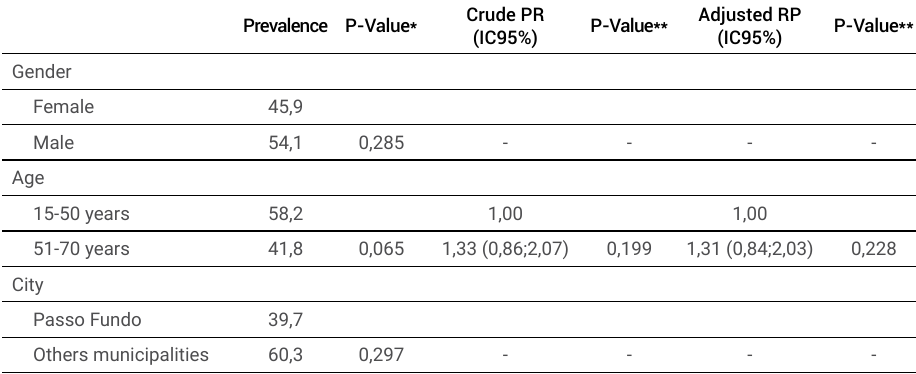
Table 3. Crude and adjusted prevalence (%) and Prevalence Ratio (PR) of non-adherence to definitive restoration after endodontic treatment, Brazil, 2020 (n =